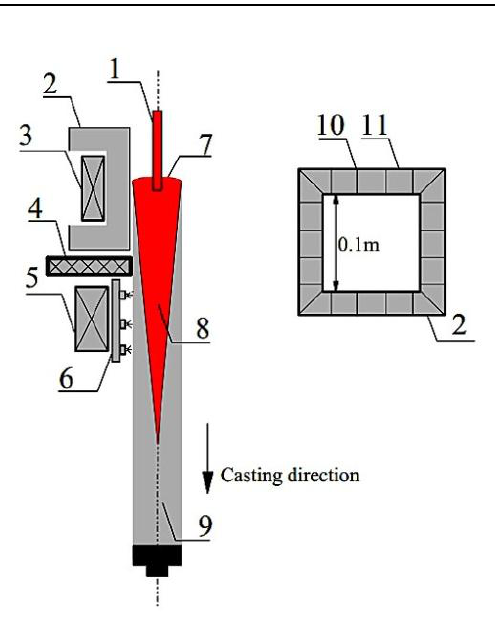
Figure 1. Schematic representation of the EMCC system (not scaled). (1) Nozzle, (2) mould, (3) high frequency induction coil for electromagnetic continuous casting (EMCC), (4) working platform, (5) electromagnetic stirring system (EMS), (6) water spray system, (7) meniscus, (8) liquid core, (9) EMCC billet (10) mould slit, and (11) mould segment.